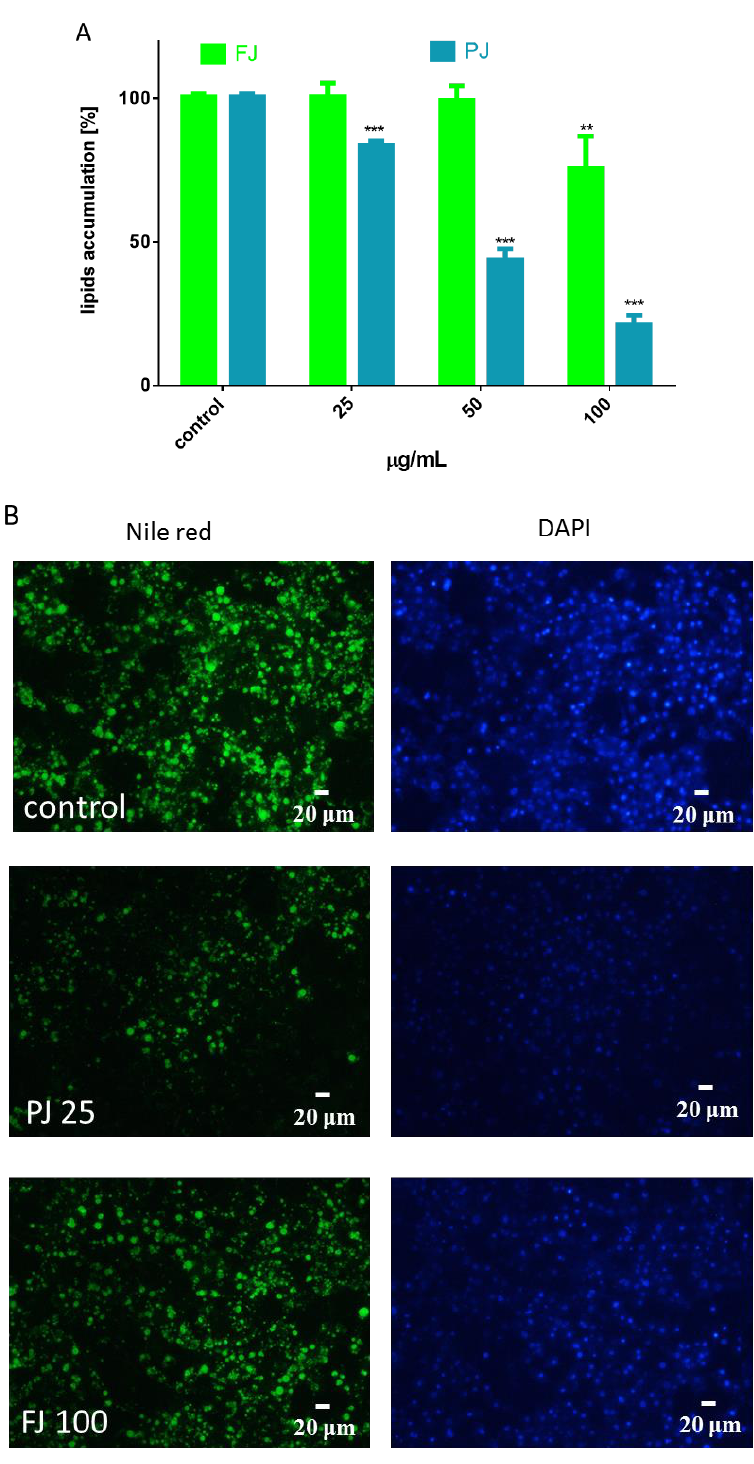
Figure 4. Influence of V. opulus FJ and PJ preparations on the accumulation of lipid droplets in 3T3-L1 cells stained with Nile red observed on the 7 th day of differentiation ( A ). The control cells were not exposed to any compound; the values are means ± standard deviations from at least three independent experiments, n ≥ 12; the statistical significance was calculated versus the control cells ** p ≤ 0.01, *** p ≤ 0.001. Cell lipid droplets with Nile red were visualized under a fluorescent microscope (200 × magnification) ( B ). DAPI staining allowed for the visualization of cell nuclei with 25 µ g / mL of PJ and 100 µ g / mL of FJ.